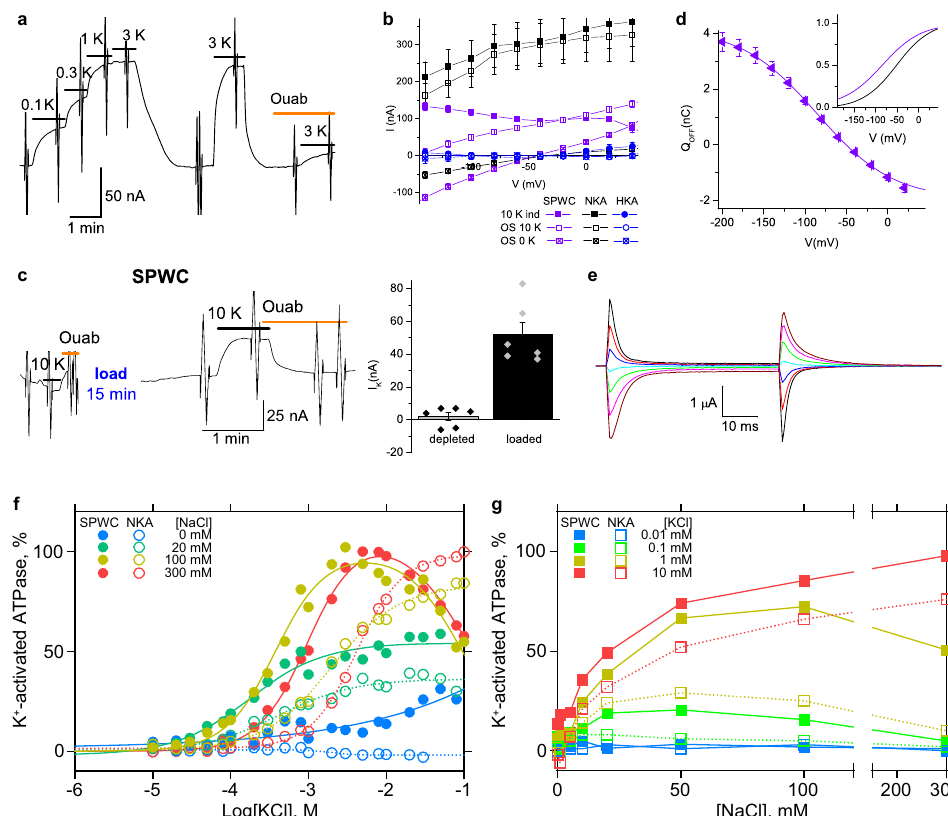
Fig. 5 | Functional and structural characterization of NKA-like SPWC-ngHKA. a Dose-dependent activation of outward current by K + in a Na + -loaded oocyte expressing SPWC-ngHKA. Application of 25mM ouabain blocked the effect of subsequentK + applications. b I – VforK + -inducedcurrent(solidpurplesquares)and for the ouabain-sensitive (OS) current measured with 10mMK + (open purple squares)orwithoutK + (crossed purplesquares).Blacksquaresandblue circlesare results for NKA and WT-HKA, respectively, in the same conditions. c Left, Appli- cation of 10mMK + on a Na + -depleted oocyte expressing SPWC-ngHKA did not activate outward current at − 50mV. In contrast, K + application following a 15-min long exposure to Na + -loading solution (during the break in the trace) activated outwardcurrent. Right, average changein K + -induced current in Na + -depleted and Na + -loaded oocytes. d Ouabain-sensitive transient currents measured as in Fig. 2c, fromanoocyte expressingSPWC-ngHKA. e MeanQ – Vcurvefrom 14experiments,